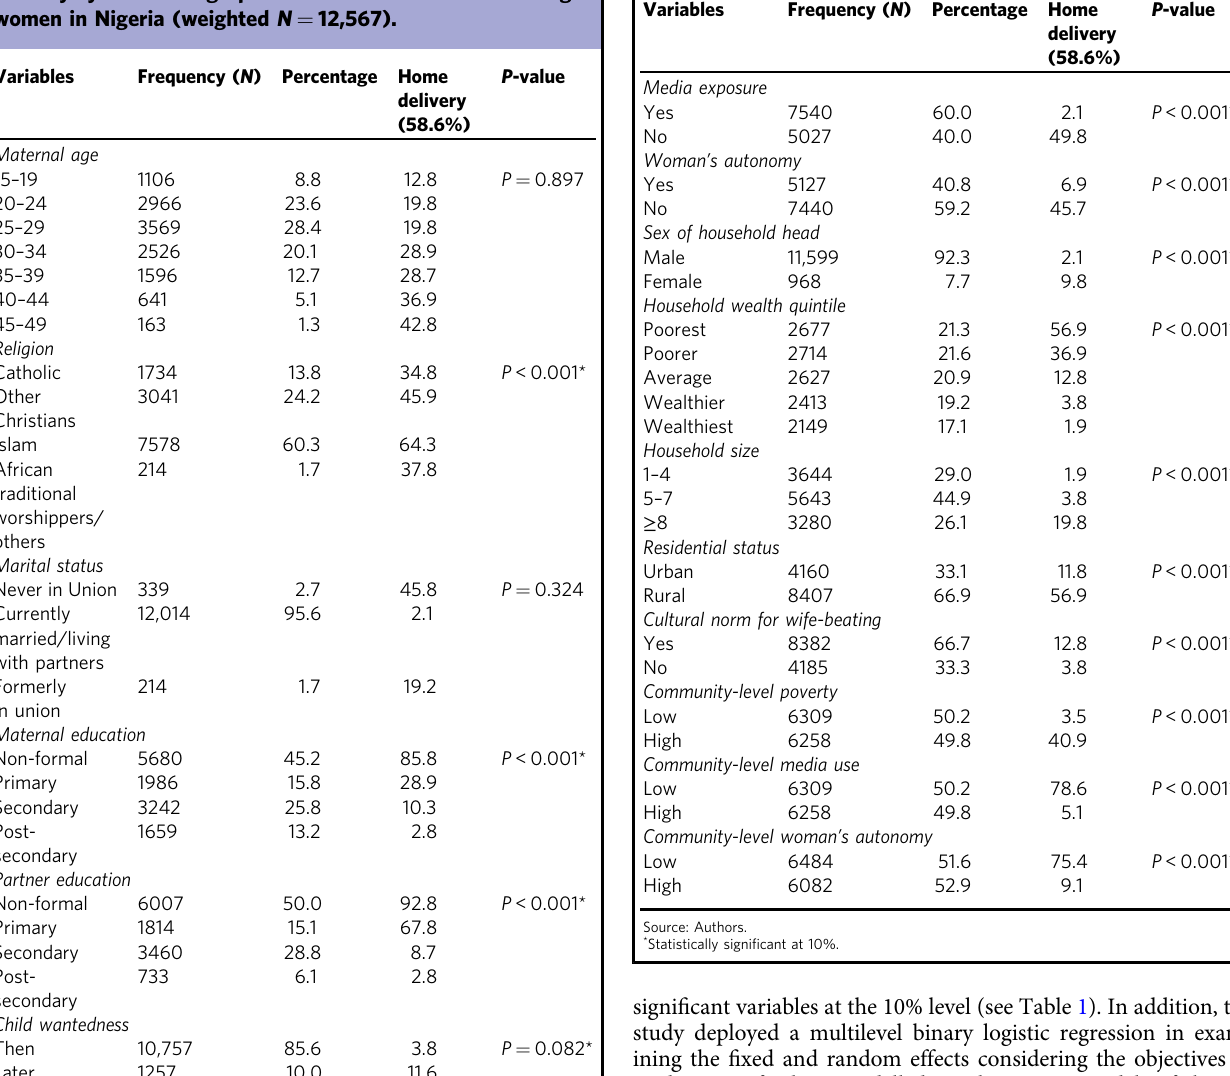
Table 1 Distribution of non-utilisation of health facility delivery by sociodemographic characteristics of childbearing women in Nigeria (weighted N =